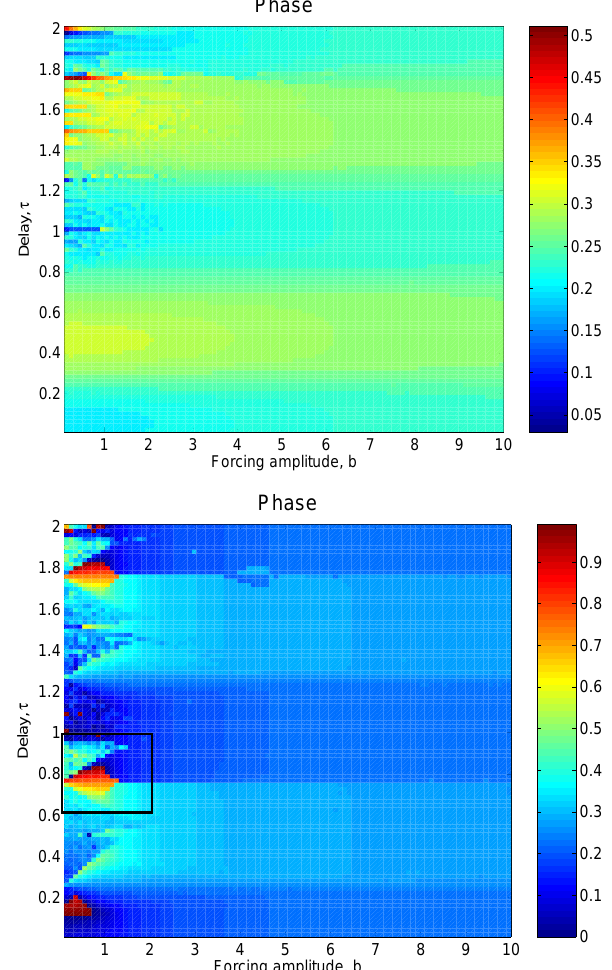
Fig. 6. Seasonal phase locking of global extrema: parameter de- pendence. The plots show the phase ϕ of the global maxima of solutions of Eq. (2) for κ = 2 . 0 (top panel) and κ = 11 . 0 (bottom panel); same number of solutions and parameter range as in Fig. 5. The rectangle in the bottom panel highlights the region blown up in Fig. 7.